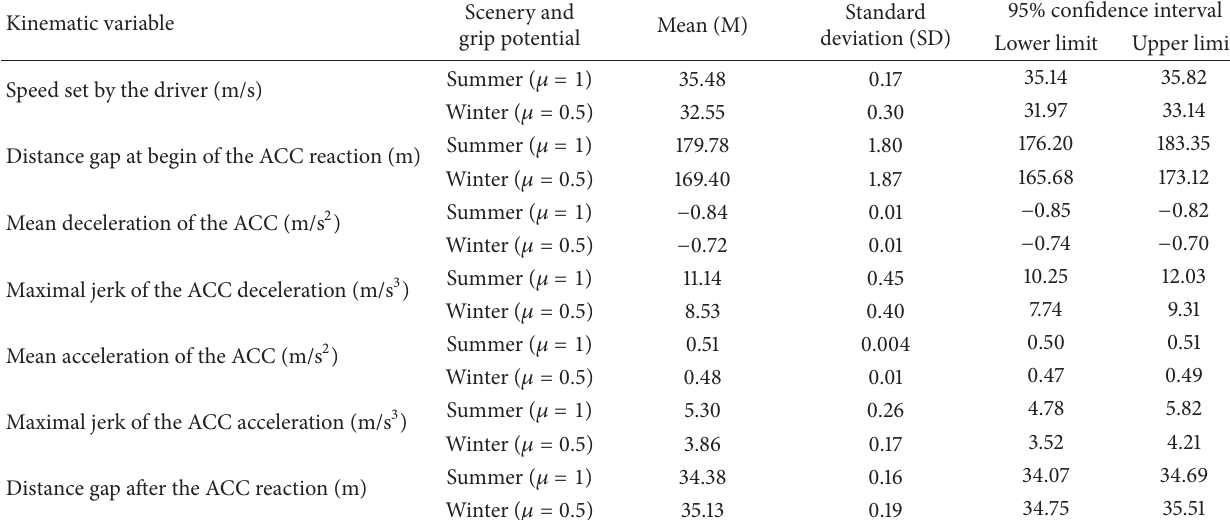
Table 2: Kinematic data of driving with ACC in both road conditions ( 𝑁 = 96 ).